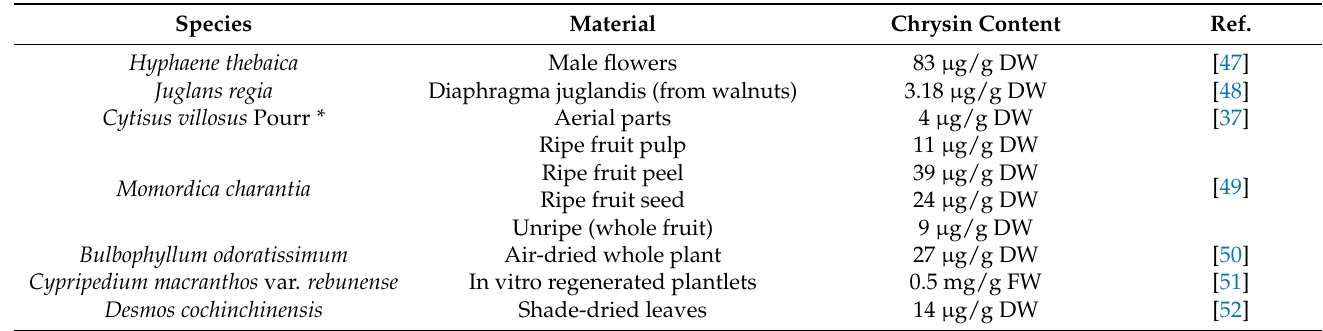
Table 3. Chrysin content of different plant materials. DW = dry weight; FW = fresh